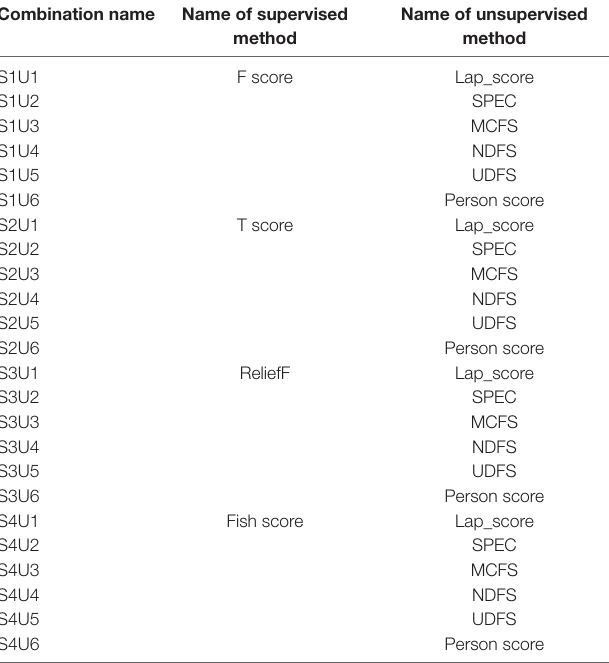
TABLE 1 | All combinations of supervised and unsupervised feature selection